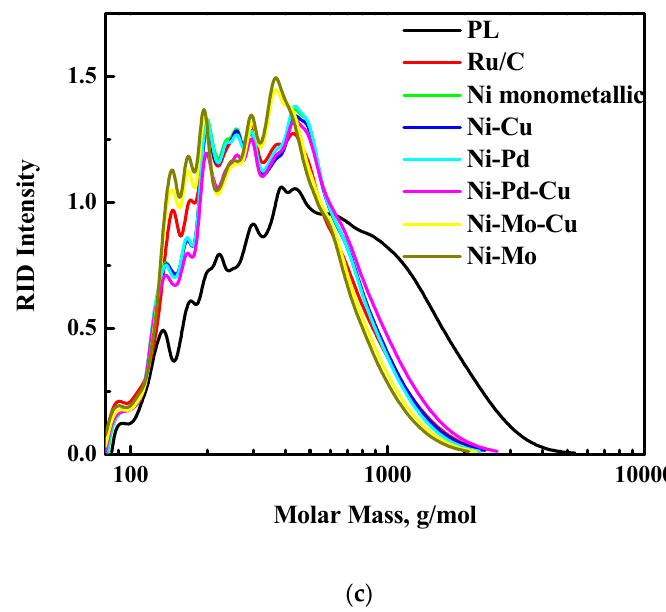
Figure 3. The molecular distribution of PS, PL and hydrogenated oils over nickel-based catalysts and Ru/C by Gel Permeation Chromatography (GPC): ( a ) GPC curves of PS feed and its hydrogenated oil products, ( b ) tail part of GPC curves from PS feed and its hydrogenated oil products, ( c ) PL feed and its hydrogenated oil products.